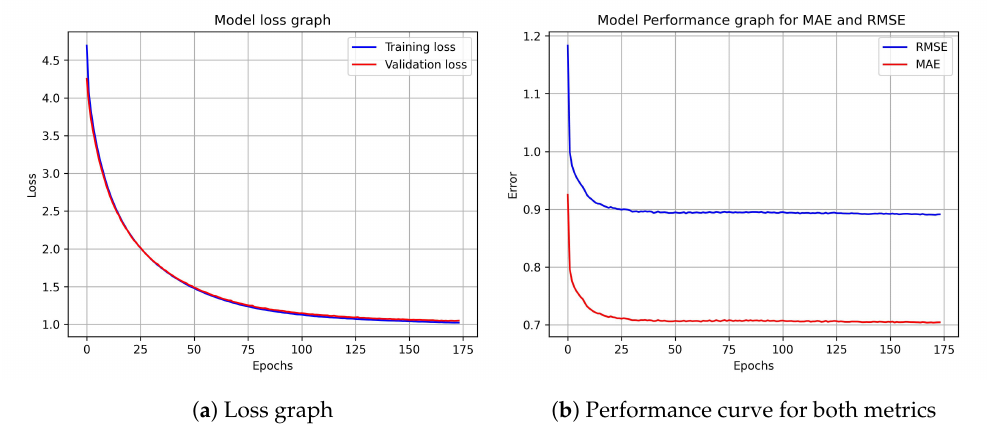
Figure 5. A four-hidden-layer model for the ML-100K dataset. In Part ( a ), we have the training and validation loss curve versus several training epochs, and in Part ( b ), we have the performance results. As observed, the method